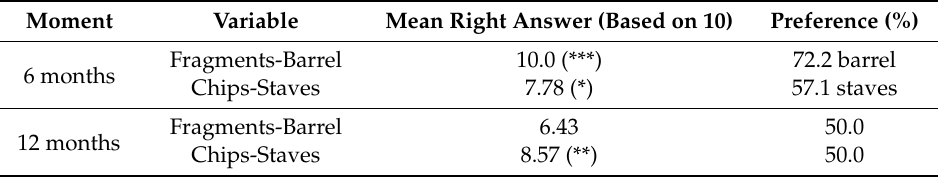
Table 1. Results of the sensory evaluation by triangular tests.